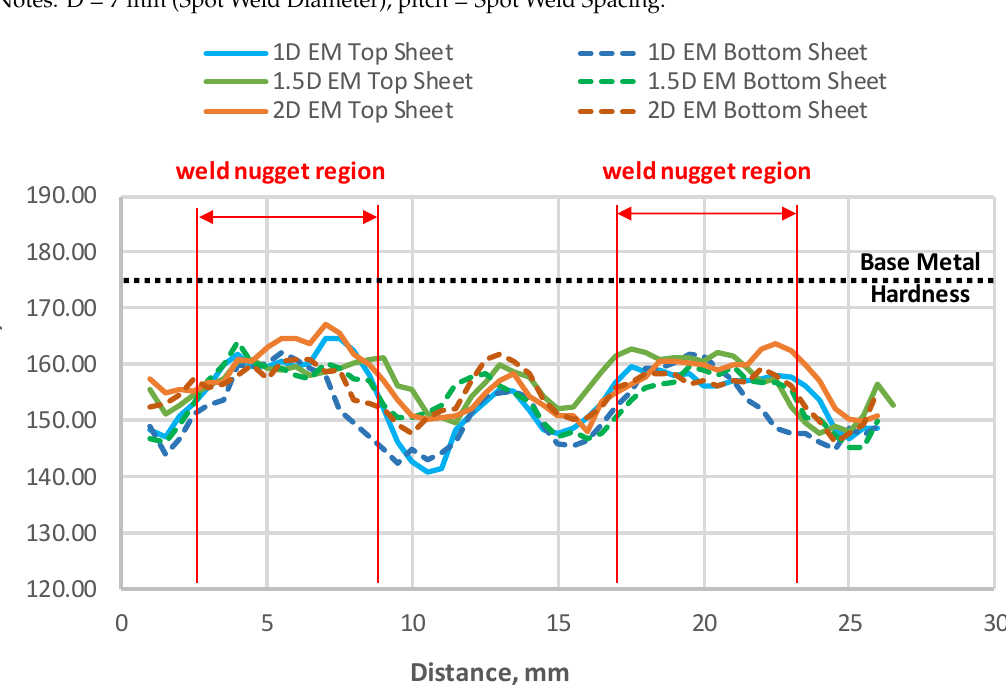
Figure 16. Microhardness values of 2D-pitch cross-section specimens. Notes: D = 7 mm (Spot Weld Diameter); pitch = Spot Weld Spacing; EM = Edge Margin.